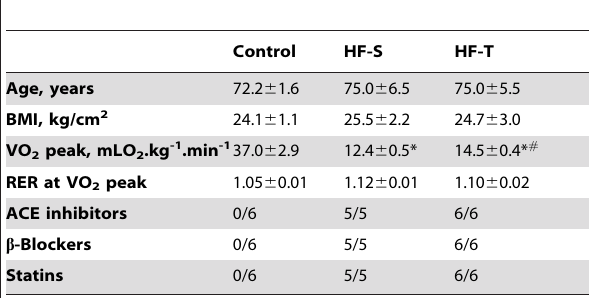
Table 3. Patient physiological